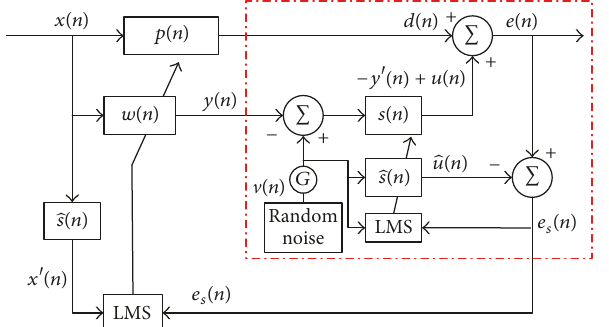
Figure 3: Proposed algorithm with prior error channel identifica-